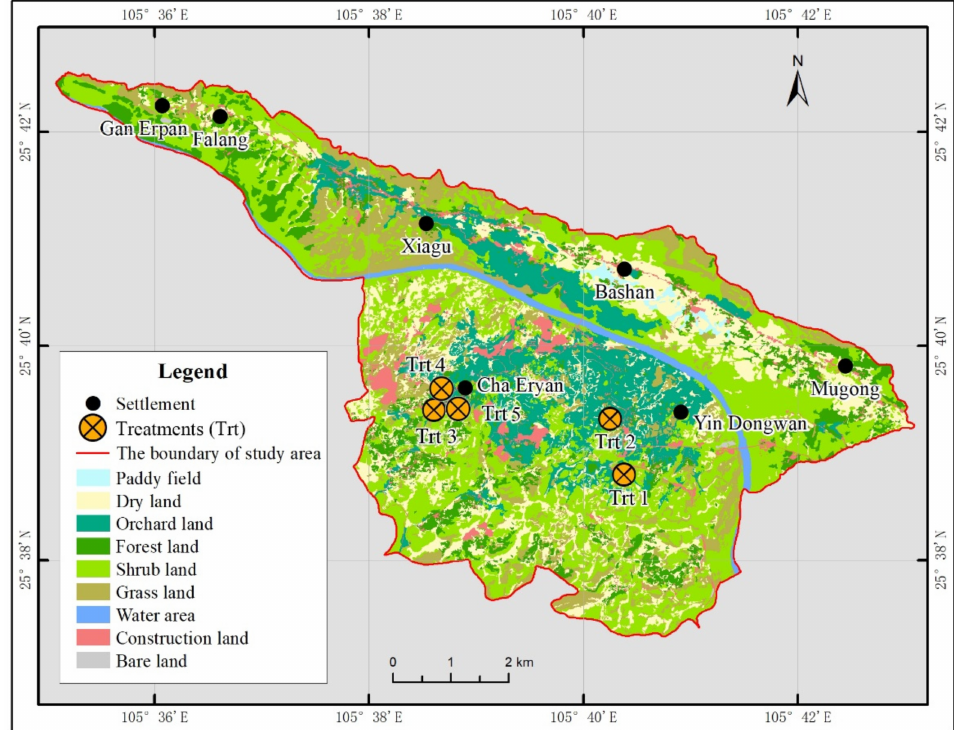
Figure 1. Distribution of treatments